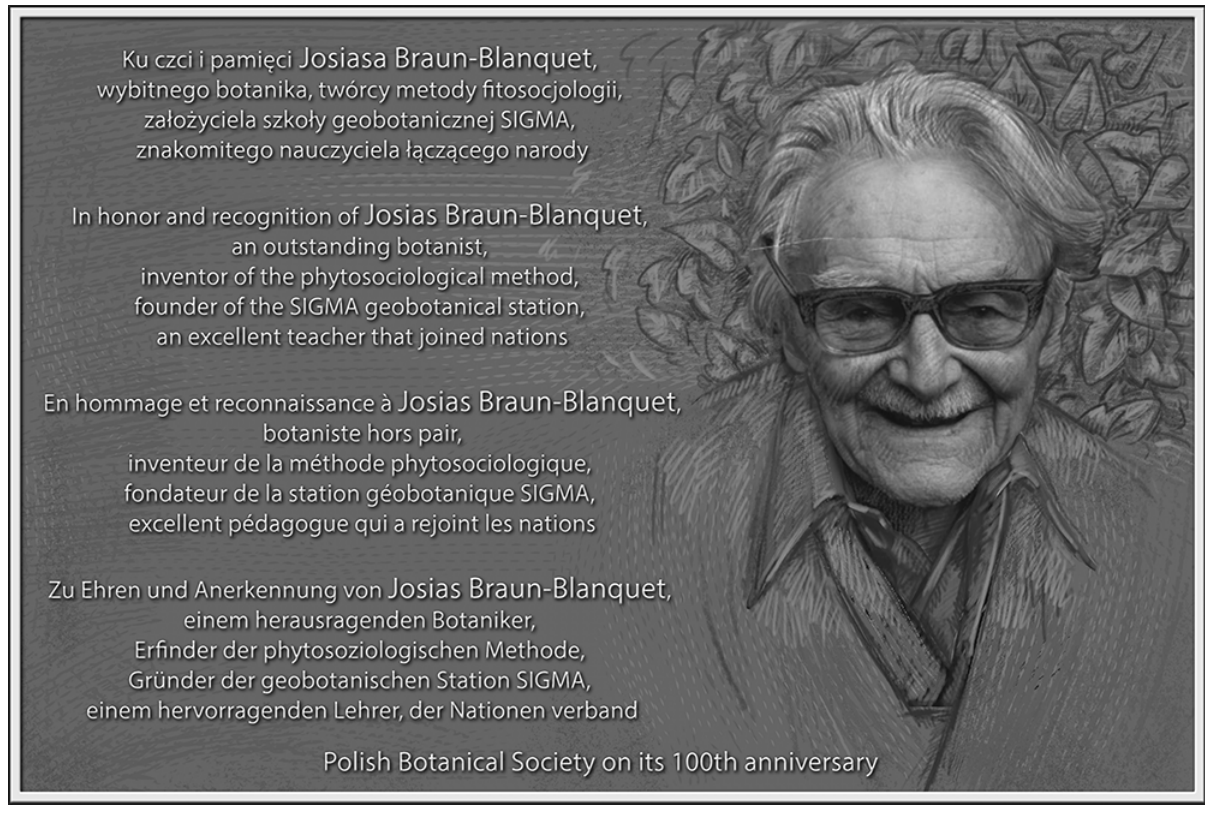
Figure 5 Drawing of a commemorative plate founded on the initiative of the Polish Botanical Society on its hundredth anniversary, commemorating the figure of Josias Braun-Blanquet (prepared by Odlew-Art,